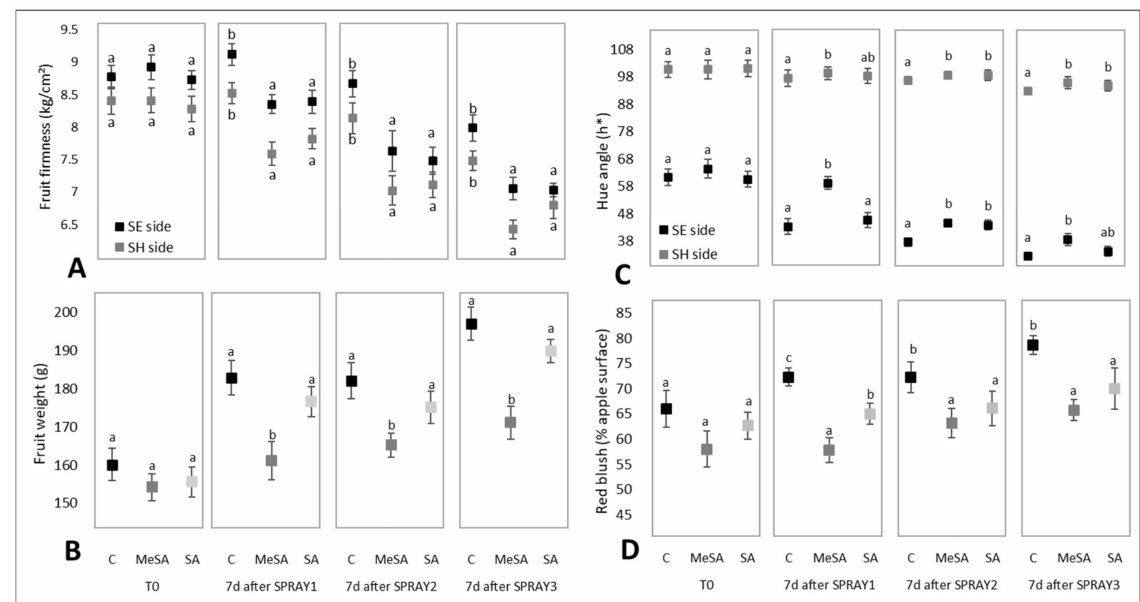
Figure 1. External quality characteristics of the apple fruit before any sprayings (T0) and 7 days after Spray#1 (SPRAY1), Spray#2 (SPRAY2), and Spray#3 (SPRAY3) for the control ( C ) and methyl salicylic acid (MeSA) and salicylic acid (SA) treatments. ( A ) Firmness on the shaded (SH) and sun-exposed (SE) sides of the fruit. ( B ) Fruit weight. ( C ) Peel hue angle on the shaded and sun-exposed sides of the fruit. ( D ) Peel red blush. Data are means ± standard error ( n = 15). Different letters indicate significant differences among the treatments within each characteristic and each sampling time ( p < 0.05; Duncan tests).